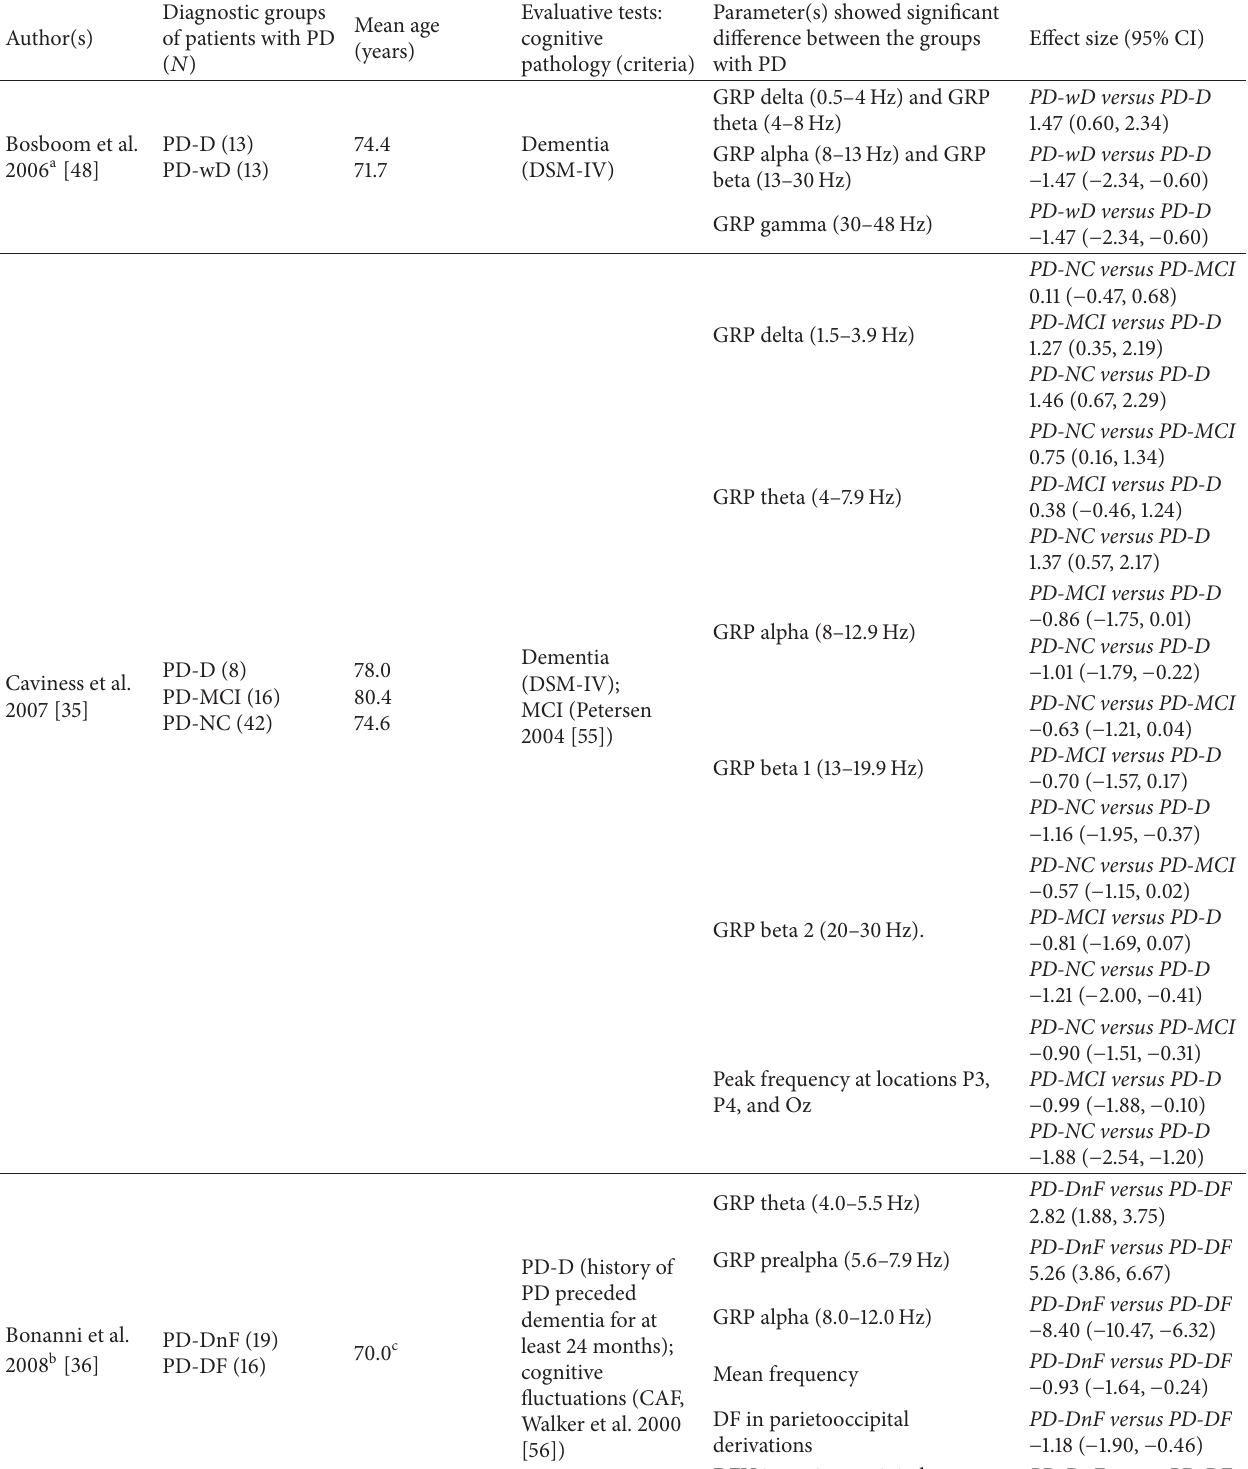
Table 2: EEG and MEG spectral markers which significantly discriminated between cognitive states in